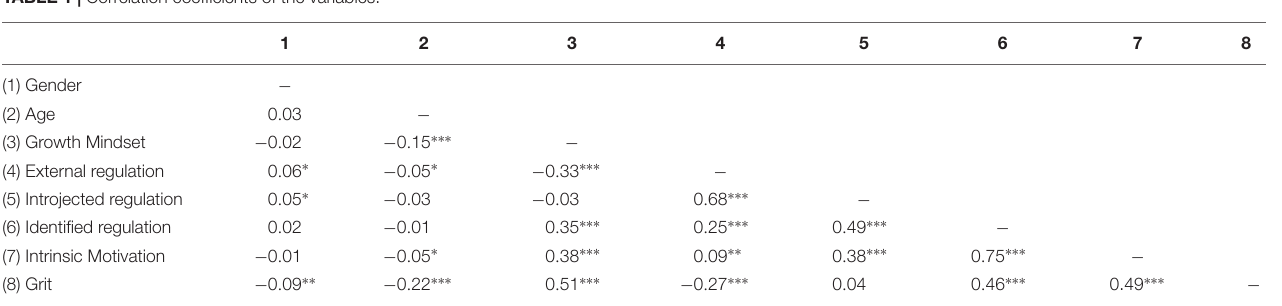
TABLE 1 | Correlation coefficients of the